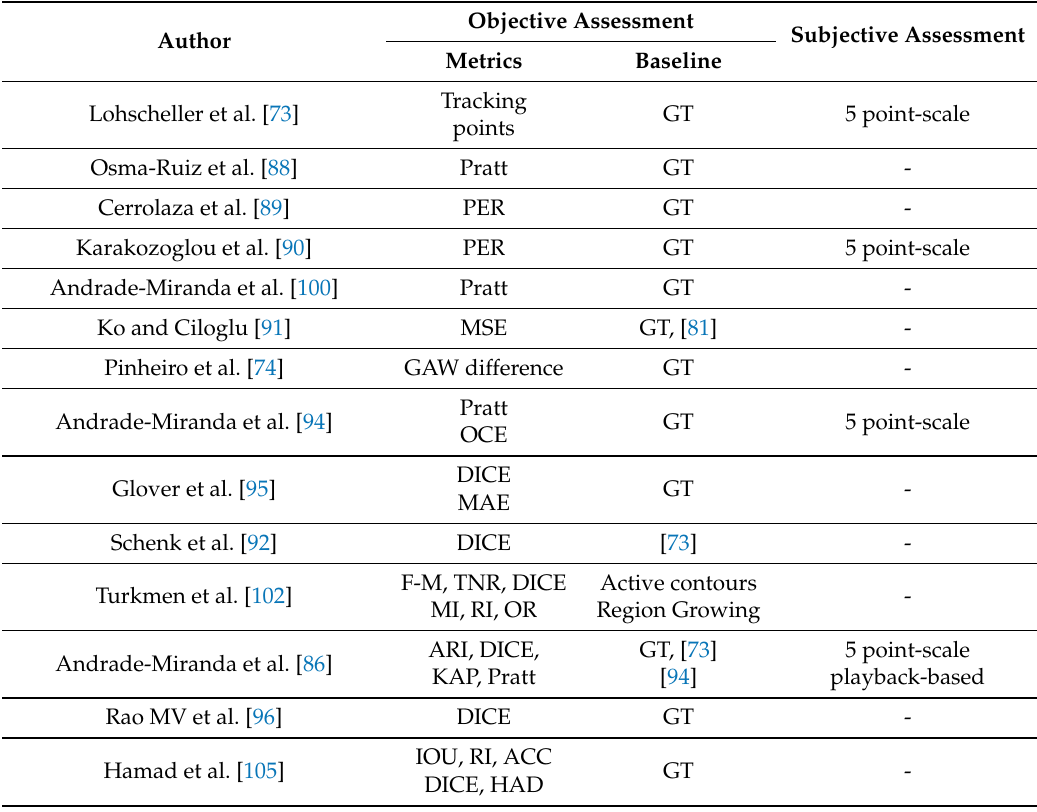
Table 3. Summary of the main methods to objectively and subjectively assess the vocal fold segmentation. First column corresponds to the authors. Second, metrics and baseline methods used for the comparison. Third, subjective assessment